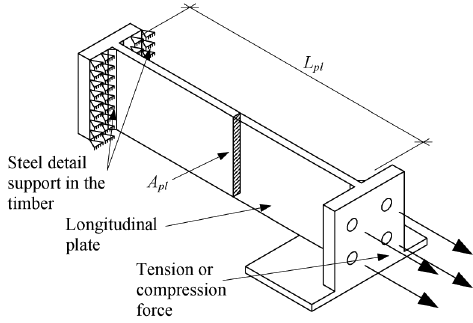
Fig. 3. Scheme for longitudinal steel plate stiffness coefficient determination